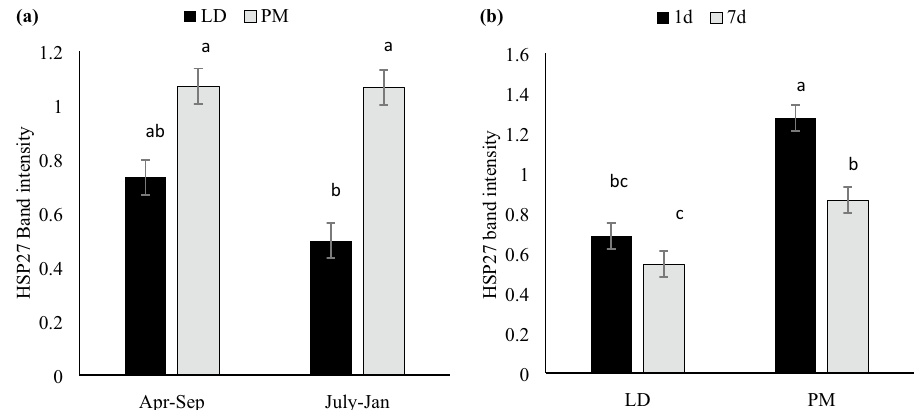
Figure 3. Densitometric analysis of HSP27 of porcine LD ( longissimus dorsi ) and PM ( psoas major ) muscles with two production replicates. (a) Muscle by replicate interaction (P = 0.024); (b) Muscle by aging interaction (P = 0.009); Results were displayed as means ± standard error. (a–c) Means with different number are significantly different (P < 0.05). July–Jan: Pigs weaned in July 2016 and harvested in January 2017; Apr–Sep: Pigs weaned in April 2017 and harvested in September 2017.